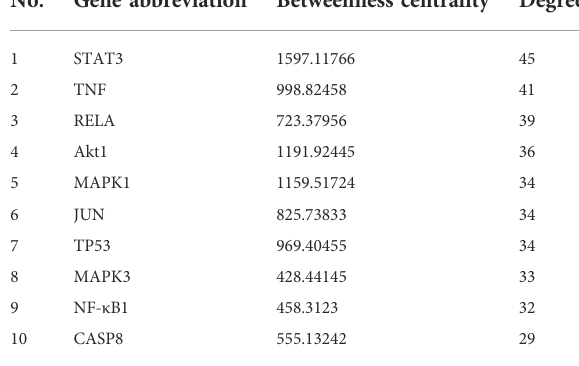
TABLE 1 The top 10 targets of tripterine in the treatment of